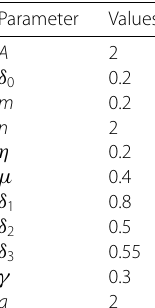
Table 1 Parameter for Figs. 1–5